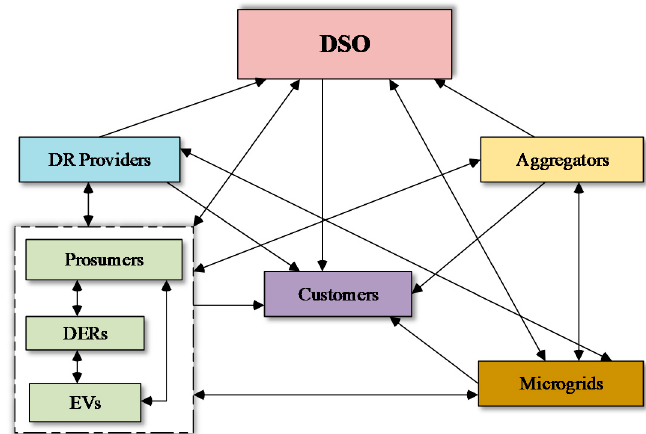
Figure 2. Overview of the local distribution market.